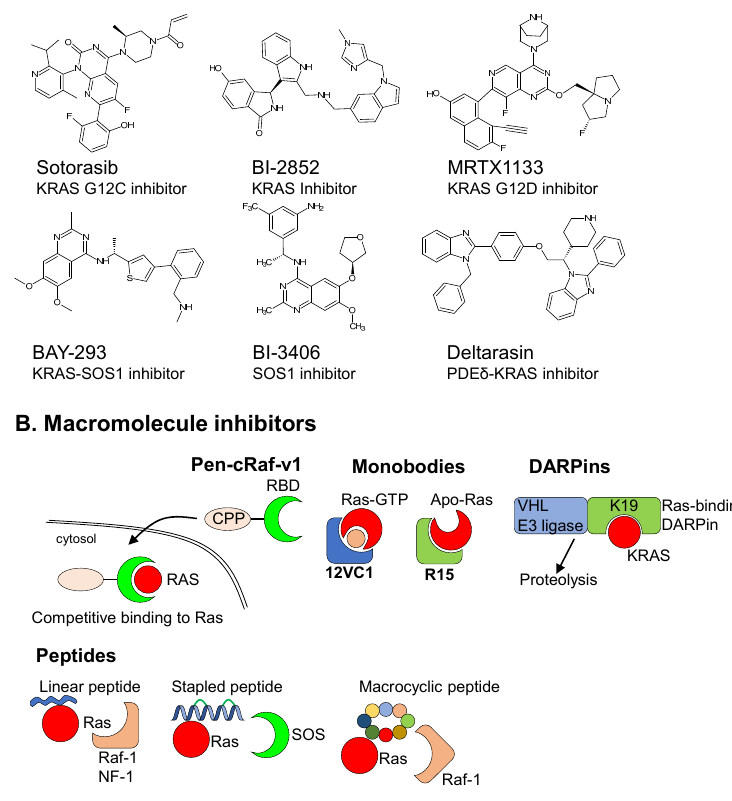
Figure 2. Key small molecule inhibitors ( A ) and macromolecule inhibitors ( B ) of Ras.